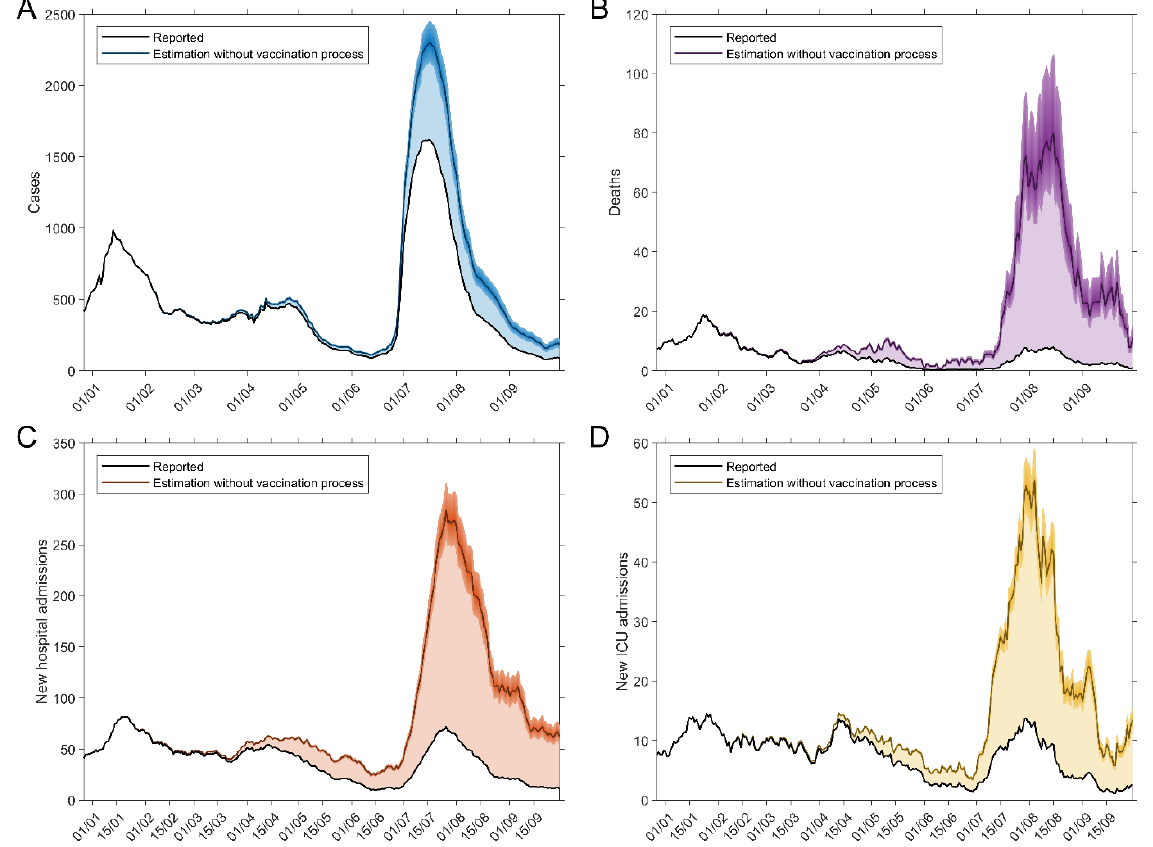
Figure 2. Epidemiological developments with and without the effect of vaccines. ( A ) Cases. ( B ) Deaths. ( C ) New hospitalizations. ( D ) New ICUs.